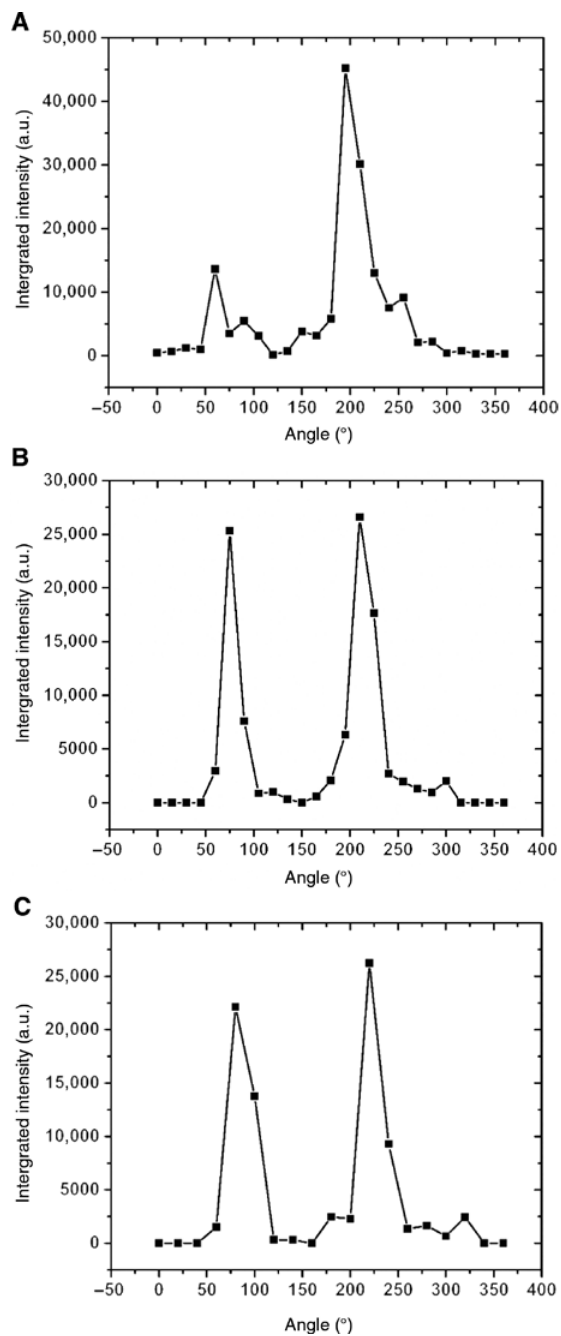
Figure 8: Relationship between the laser emission intensity and output direction at a sampling frequency of 15 ° , for gain medium concentrations of (A) 5, (B) 4 and (C) 3 mmol/l.